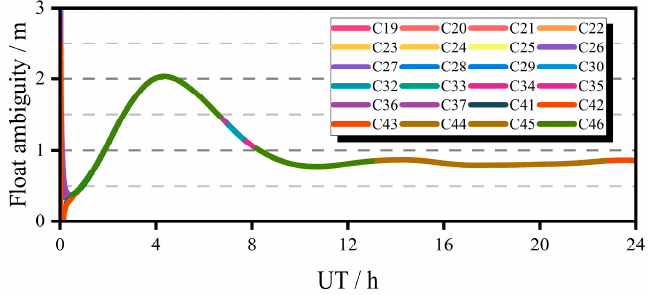
Figure 16. Differences of floating ambiguity of IF123-0 model at AREG.